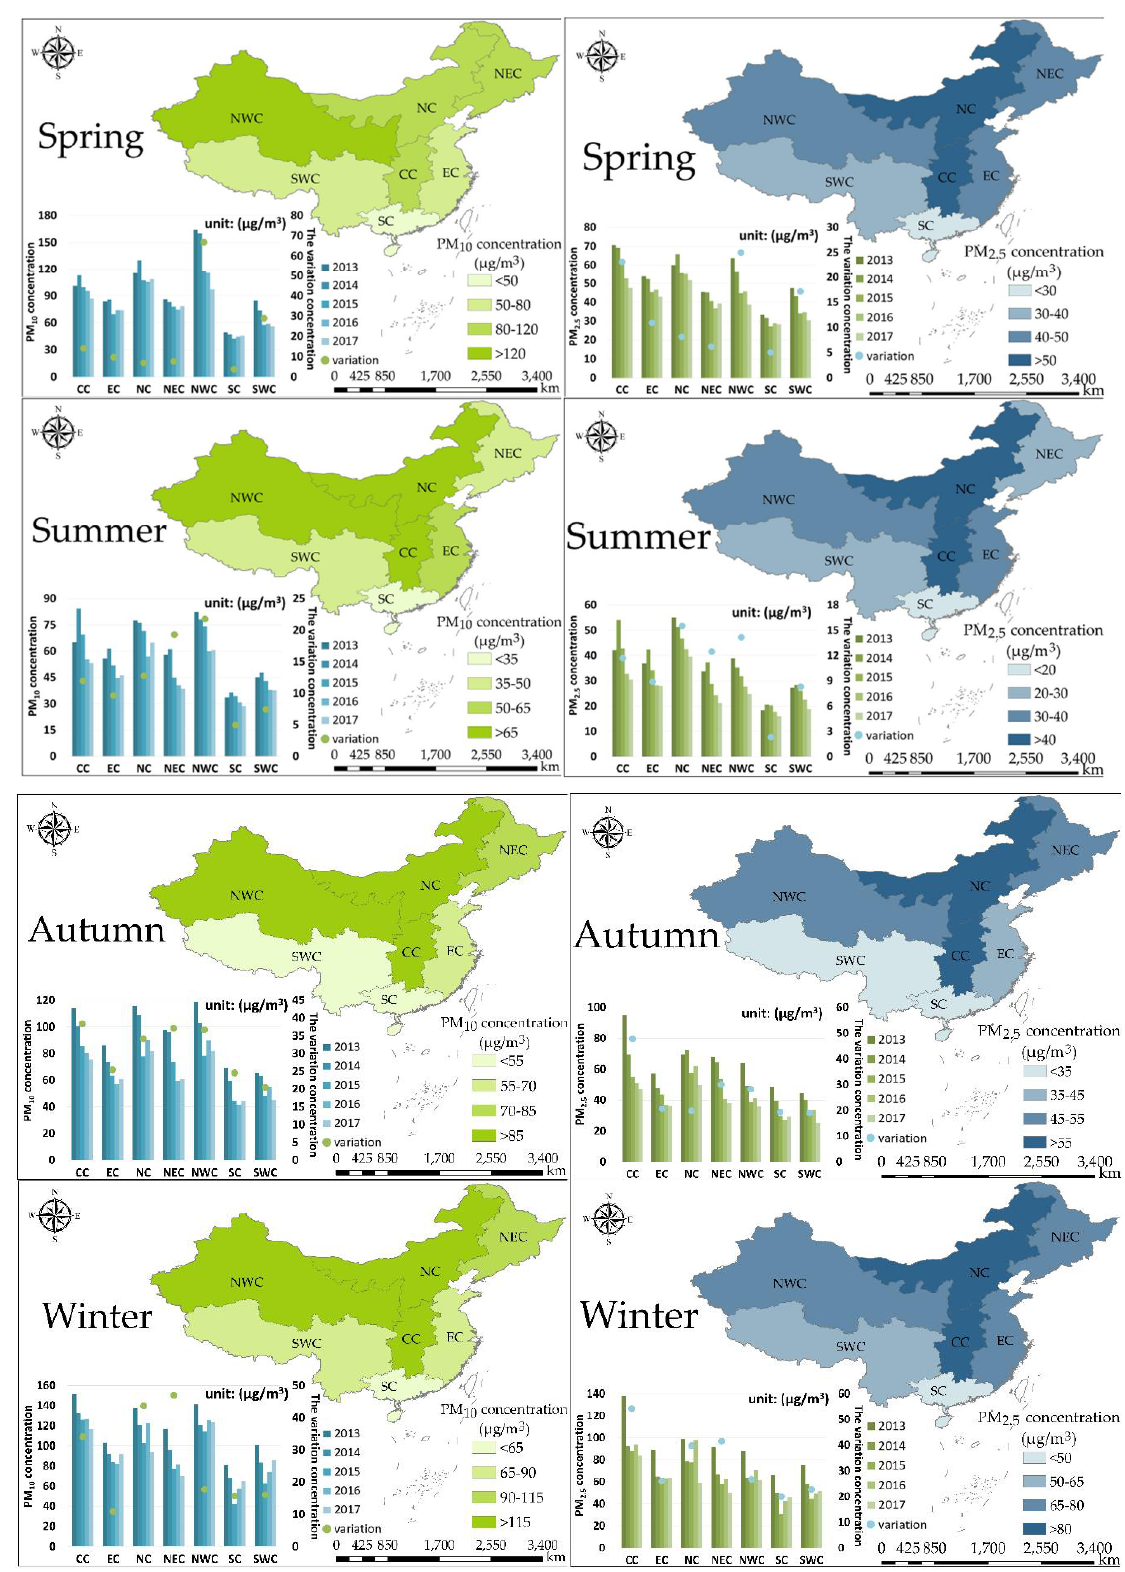
Figure 7. The characteristics and variations of PM 10 and PM 2.5 concentrations in different regions of China from seasonal and interannual